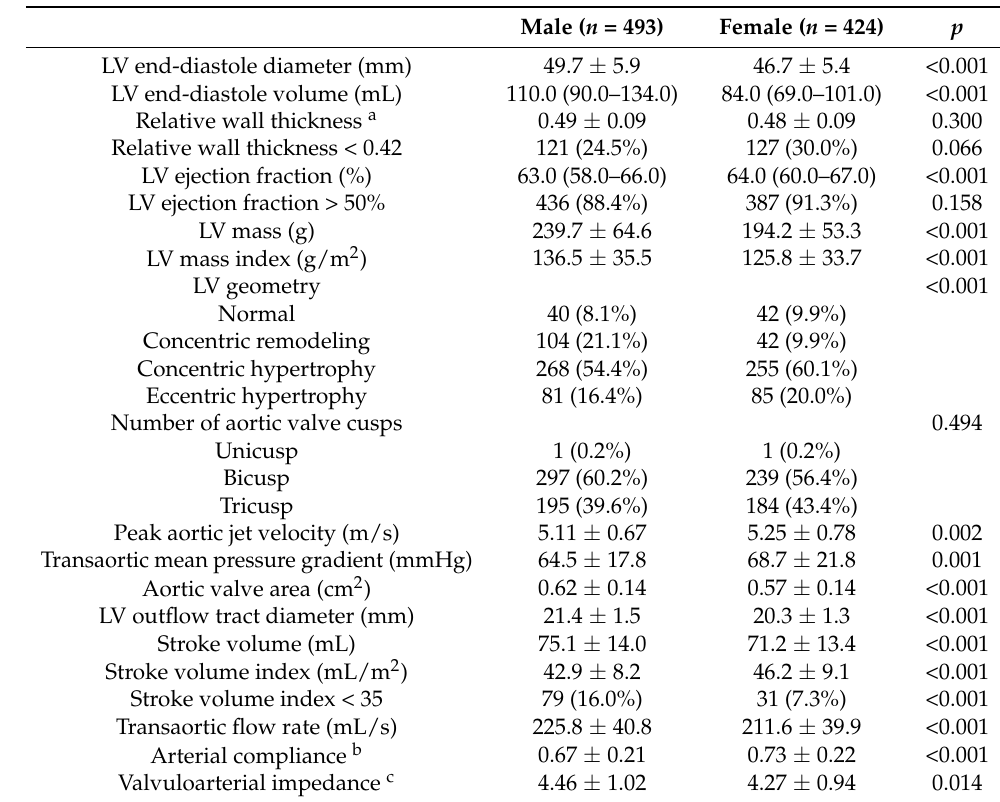
Table 2. Preoperative echocardiographic findings according to